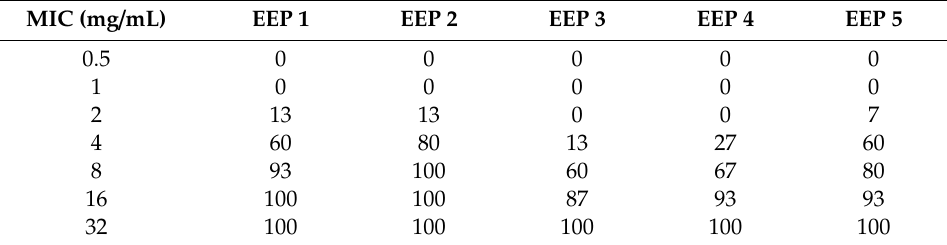
Table 7. Percentage of antifungal activity (A %).